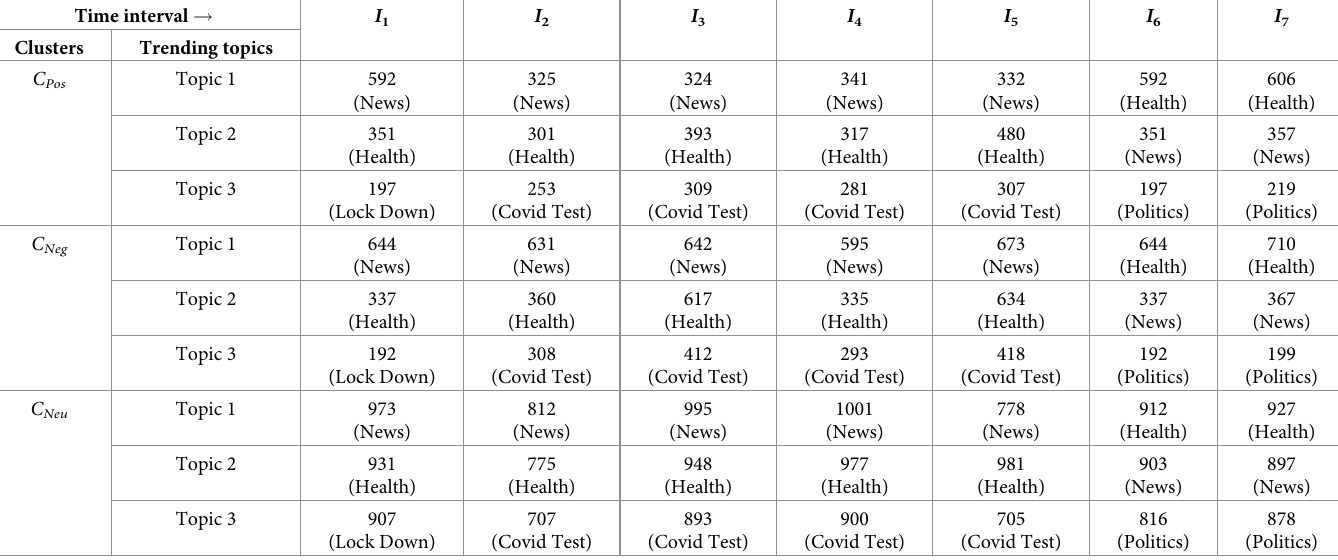
val. We sketch Fig 8 and visualize the changes in the clusters’ size precisely for a graphical representation. The size of these clusters is changing with the shift of time windows. We also notice that the neutral clusters ( C ) always have the largest sizes among all. Neu As a first evaluation measure, we find out the entropy of our mentioned positive, negative, and neutral clusters. These clusters are shown in Table 8. Hence, a good sentimental cluster Table 6. Topic-wise sentimental clusters size at different I m